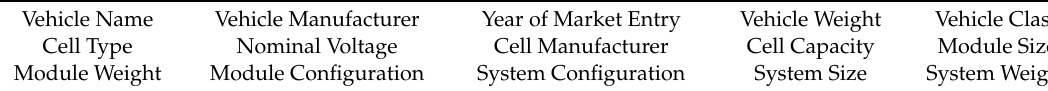
Table A1. Collected Data.